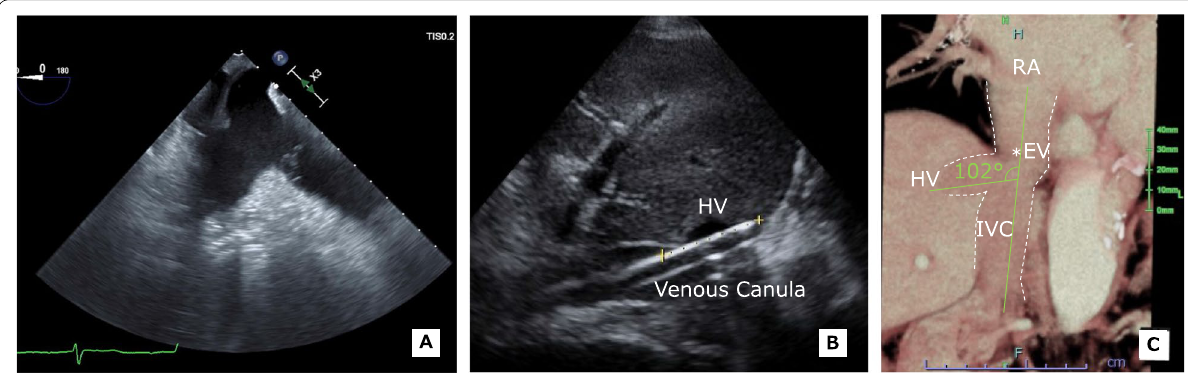
Fig. 2 Echocardiographic and CT images in case 2 with a strayed venous canula that was inserted from the FV to the HV. A TEE image of the IVC and right atrial junction. A soft tissue density that is continuous with an obvious Eustachian valve is seen at the junction of the right atrium and IVC, near the coronary sinus. B TTE image showing that the venous canula strayed into the HV. C Coronal CT image of the junction of the HV and the IVC. The angle between the IVC and the HV is 102°, which is an obtuse angle. A low-absorption density indicating the Eustachian valve is seen on the right atrial side of the junction between the HV and the IVC. CT, computed tomography; FV, femoral vein; TEE, transesophageal echocardiography; IVC, inferior vena cava; EV*, Eustachian valve; RA, right atrium; HV, hepatic vein; RV, right ventricle; TV, tricuspid valve;